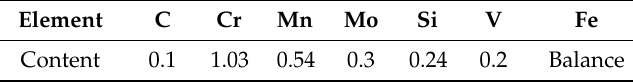
Table 1. Chemical composition of 12Cr1MoV steel